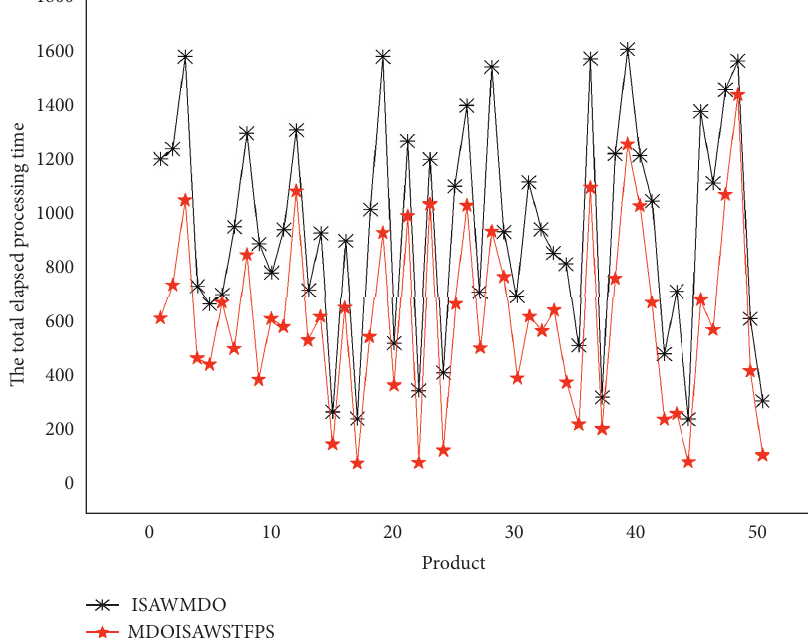
Figure 12: Comparison of the total elapsed processing time when the number of multiequipments is 5 for the two